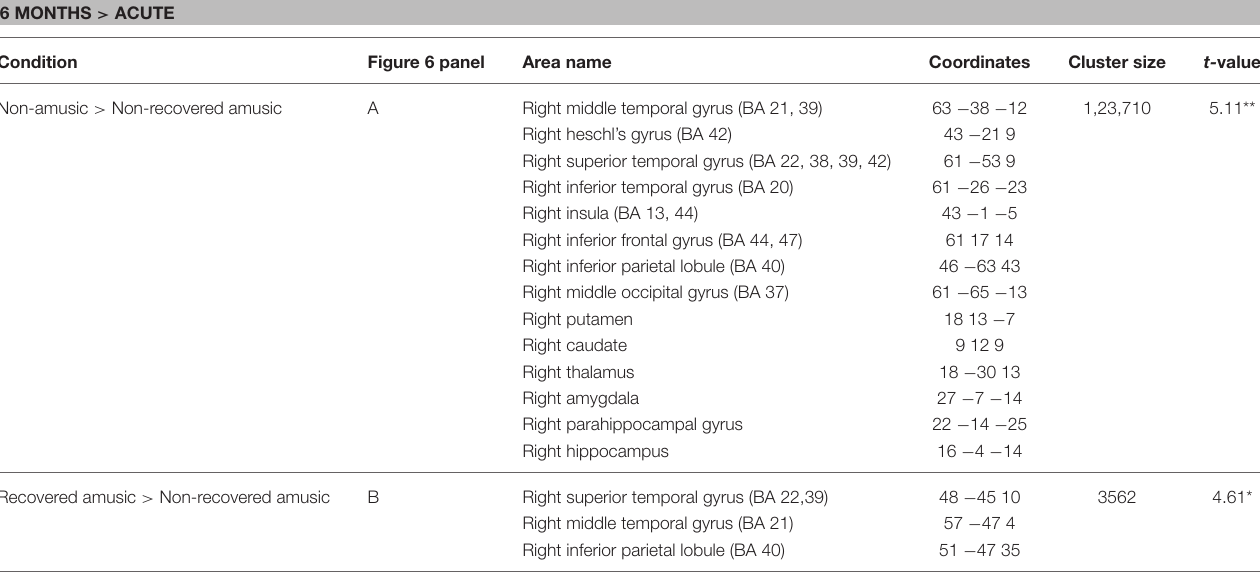
TABLE 4 | Gray matter volume decreases (6-month stage—acute stage) in pitch amusia: pooled